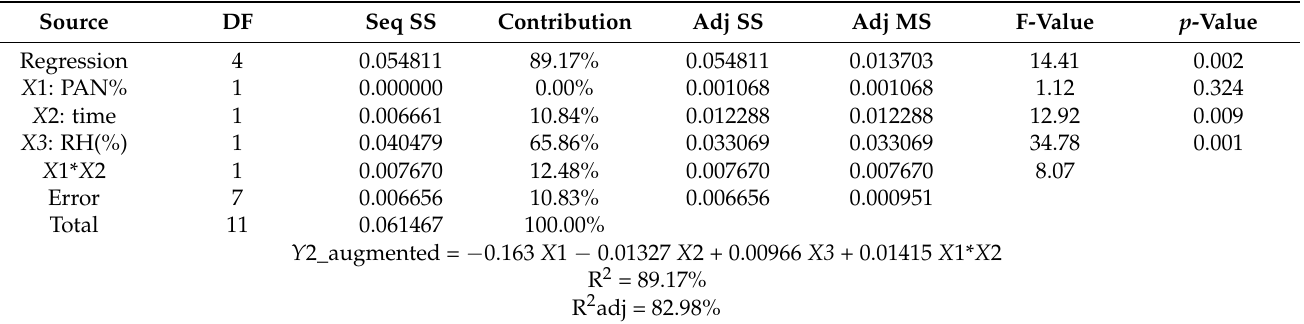
Table 7. The ANOVA for the model of output variable Y 2 in coded variables augmented with interaction term X 1* X 2. The term X 1, could be removed to obtain a reduced